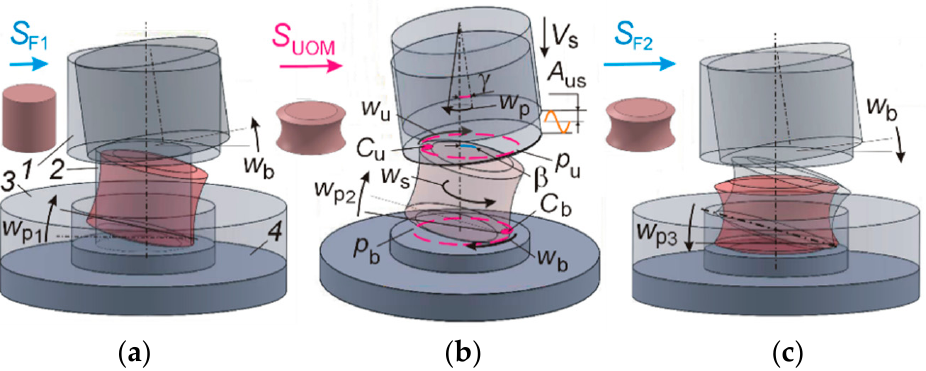
Figure 8. The course and parameters of the UOM process: ( a ) end of the phase S F1 /start of the phase S UOM ; ( b ) phase S UOM ; ( c ) end of the phase S UOM /start of the phase S F2 ; description in the text.